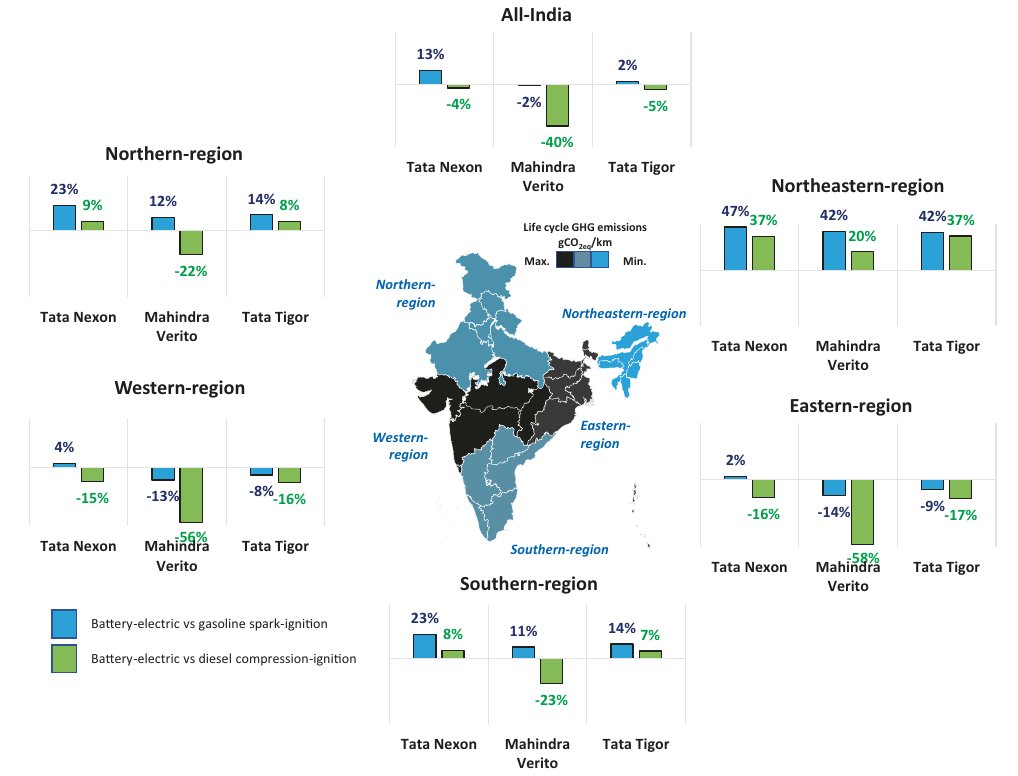
Fig. 1 GHG emission reduction potential of electric 4-wheelers in India. A positive value denotes the percentage emission reduction, while a negative value means that the BEV emits higher GHG than its gasoline/diesel counterparts. The life cycle GHG emissions of BEVs in India vary signi fi cantly based on individual regions ’ power generation pro fi les, with the generation mix assumed to be static throughout the vehicle lifetime. There are larger overall GHG emission bene fi ts for BEVs in the north-eastern region and to a lesser extent in the northern and southern regions. The climate change mitigation potential of a BEV is diminished when contrasted against diesel engines. Supplementary Fig. 8 provides additional